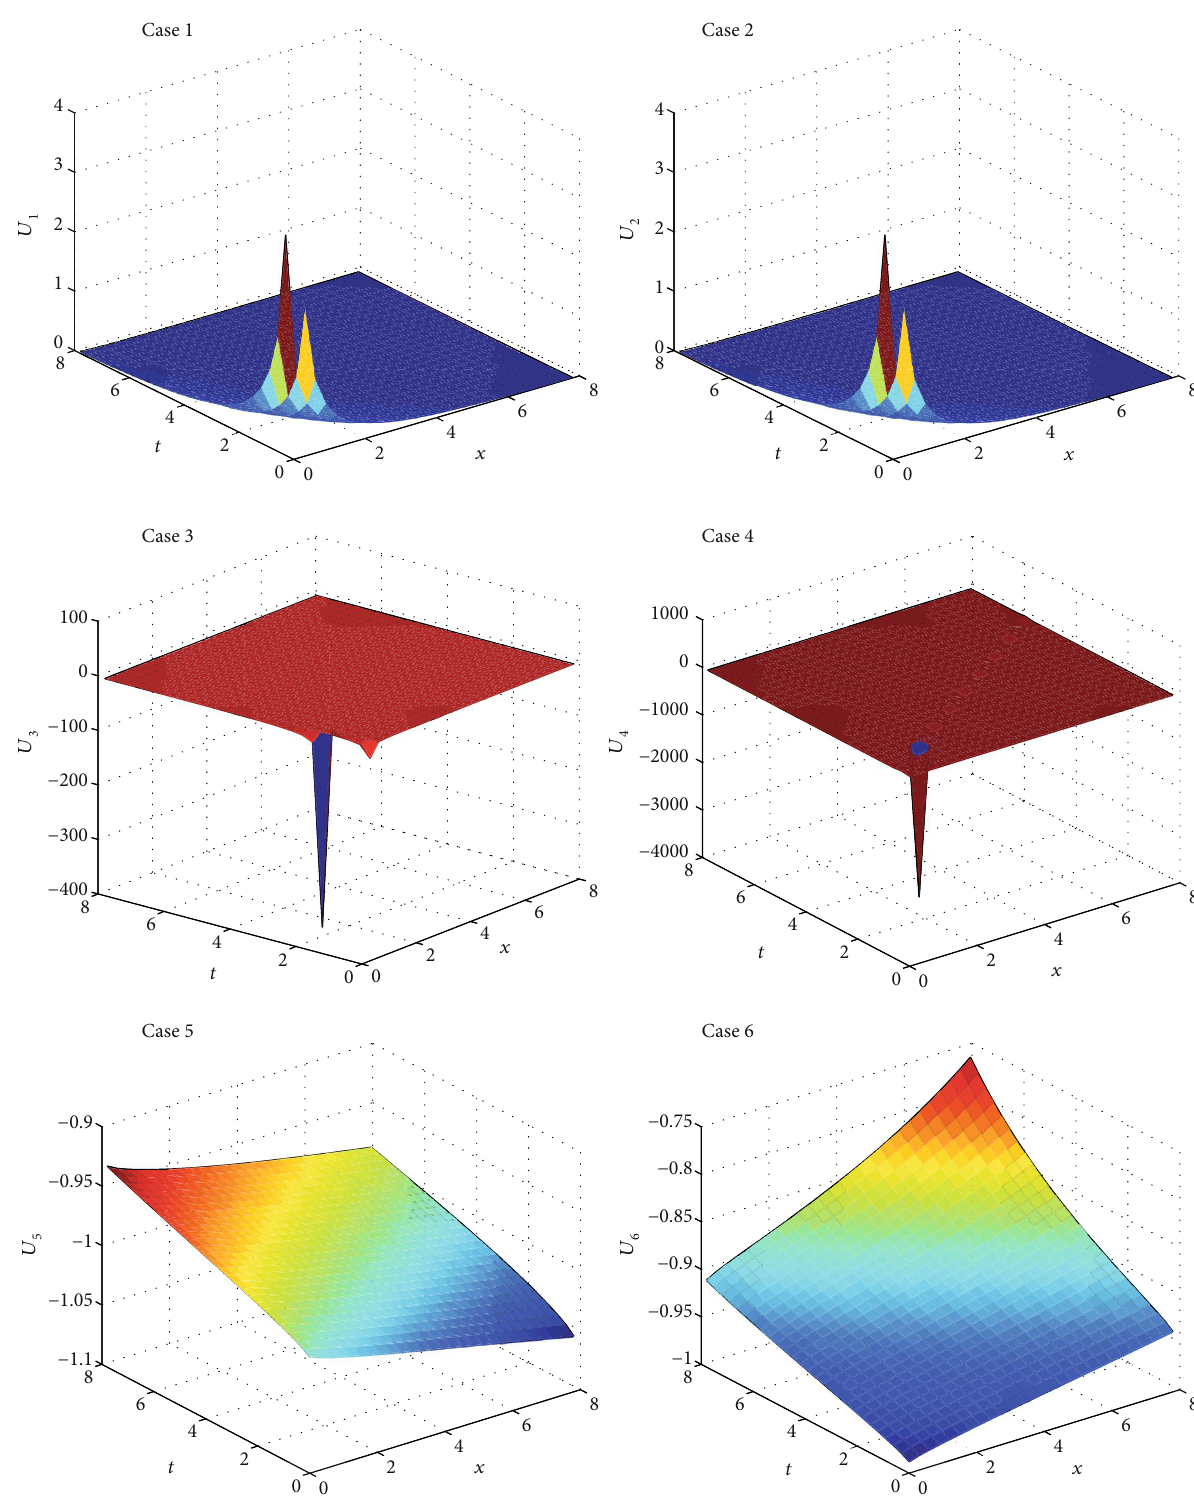
Figure 1: Solutions of conformable fractional KPP equation Cases 1 – 6 using η = 1 : 93 − 2 : 25 , m = 1 , δ = 1 , γ = 1 , and β = 0 : 8